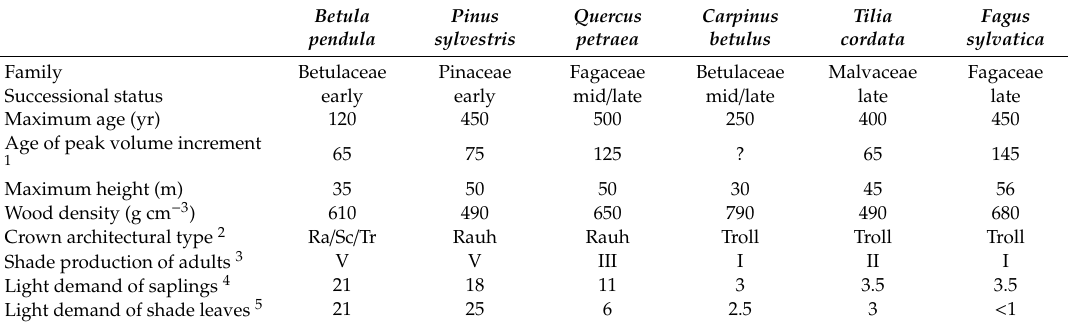
Table 1. Some morphological and functional characteristics of the six studied tree species (after various sources, including [33–35]). The species are arranged according to their seral status in forest succession. Betula Pinus Quercus Carpinus Tilia Fagus pendula sylvestris petraea betulus cordata sylvatica Family Betulaceae Pinaceae Fagaceae Betulaceae Malvaceae Fagaceae Successional status early early mid / late mid / late late late Maximum age (yr)